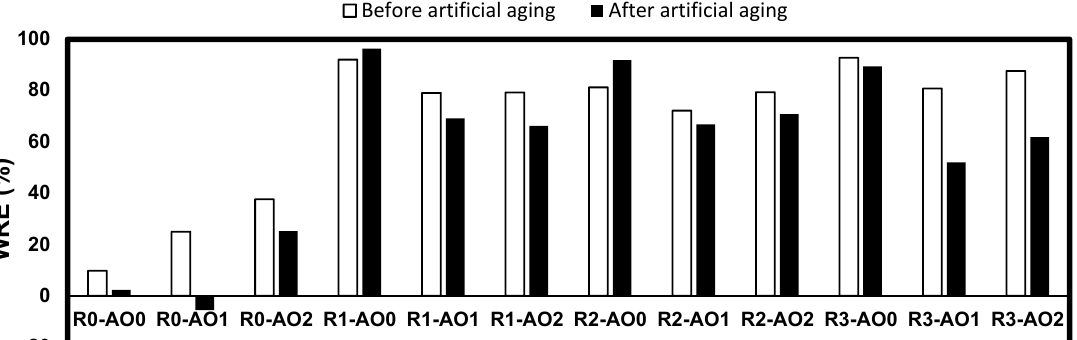
Figure 3. Water repellent efficiency (WRE) of the white pine before and after artificial aging